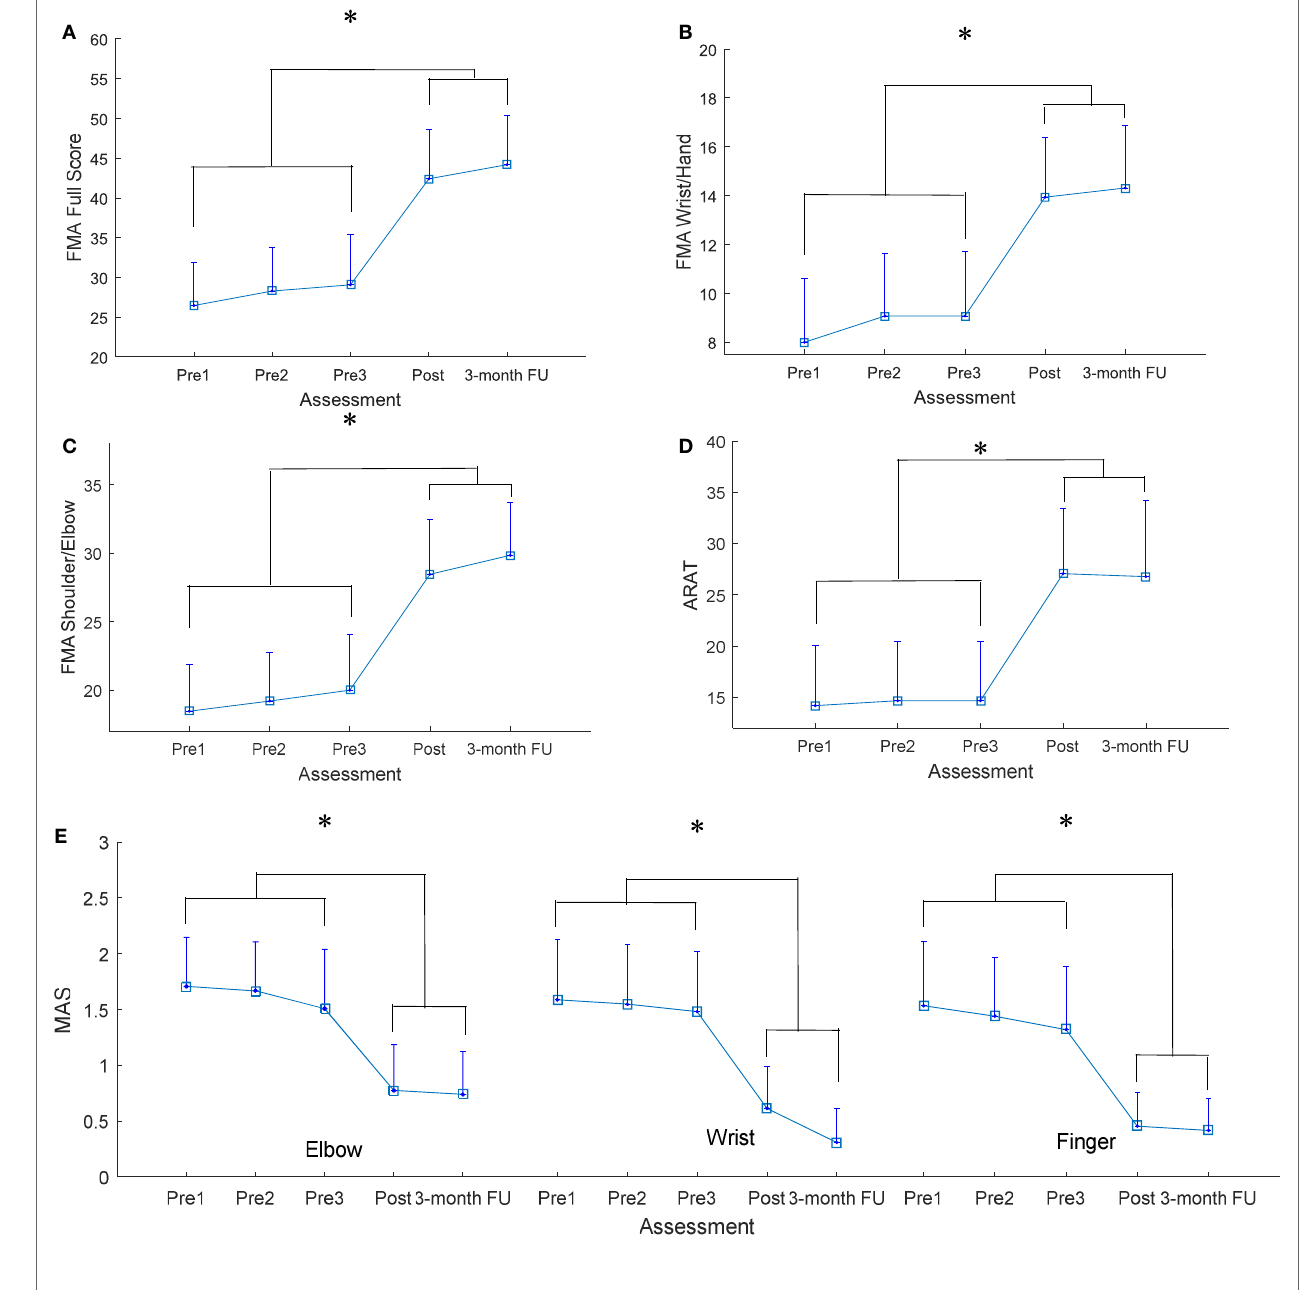
FiGUrE 4 | The clinical scores measured before, after, and 3 months later after the training (a) Fugl-Meyer Assessment (FMA) full score, (B) FMA wrist/hand score, (C) FMA shoulder/elbow score, (D) Action Research Arm Test (ARAT) score, (E) Modified Ashworth Scale (MAS) score at the elbow, the wrist, and the fingers, presented as mean value with two times SE (error bar) in each evaluation session. The significant difference is indicated by “*” ( P < 0.05, one-way analysis of variance with Bonferroni post hoc